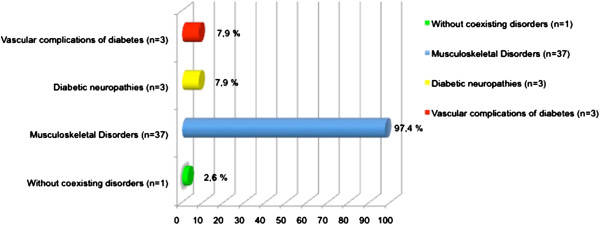
Other somatic disorders.